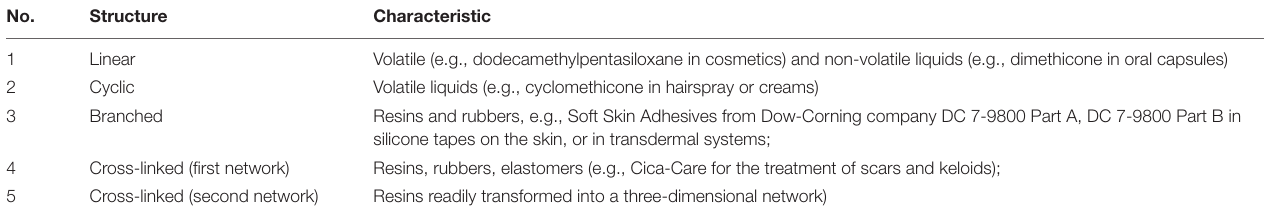
TABLE 1 | The characteristic of principal structures of